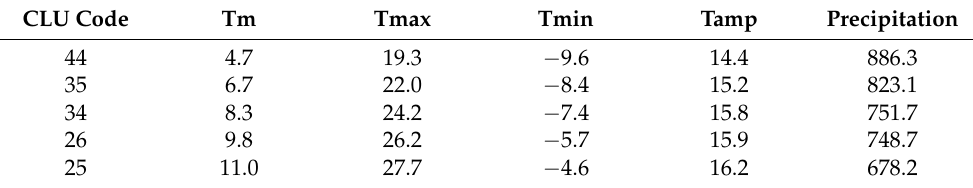
Table 2. Annual mean (Tm, ◦ C), highest (Tmax, ◦ C), and lowest (Tmin, ◦ C) monthly temperature and annual precipitation (mm) for each climate unit (CLU) as input in CBM or Yasso15. Tamp ( ◦ C) represents the half of the difference between maximum and minimum monthly temperatures. CLU Code Tm Tmax Tmin